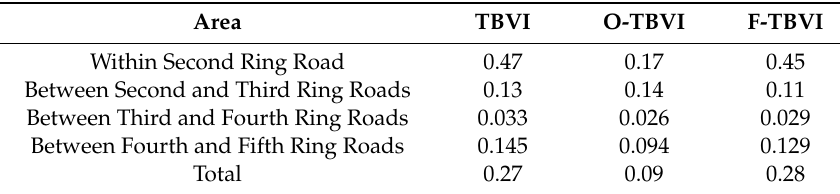
Table 5. Moran’s I of the Chinese traditional-style